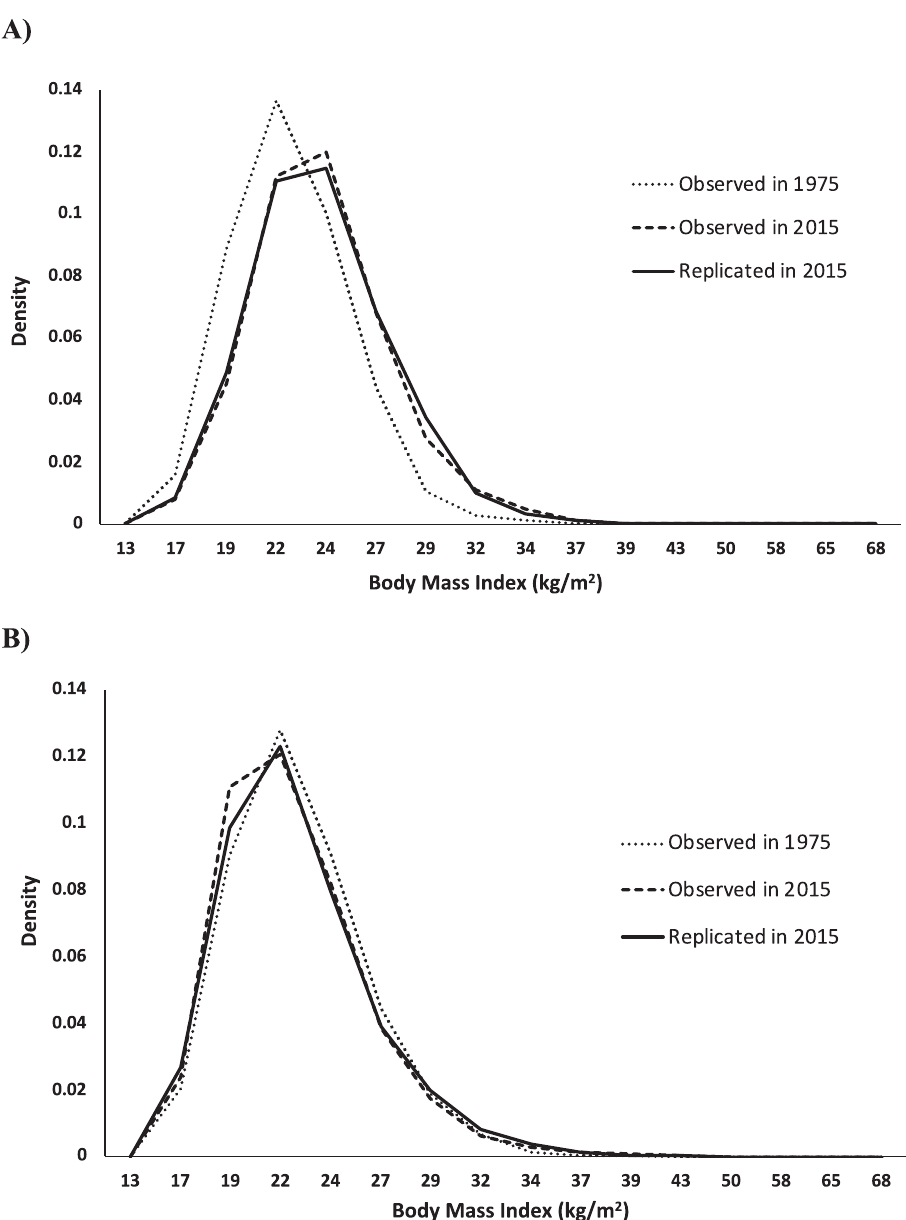
Figure 3. Observed body mass index distributions from the Japan National Health and Nutrition Survey in 1975 and 2015 and the distribution in 2015 replicated by the system dynamics model for Japanese (A) men and (B) women aged 20 to 74